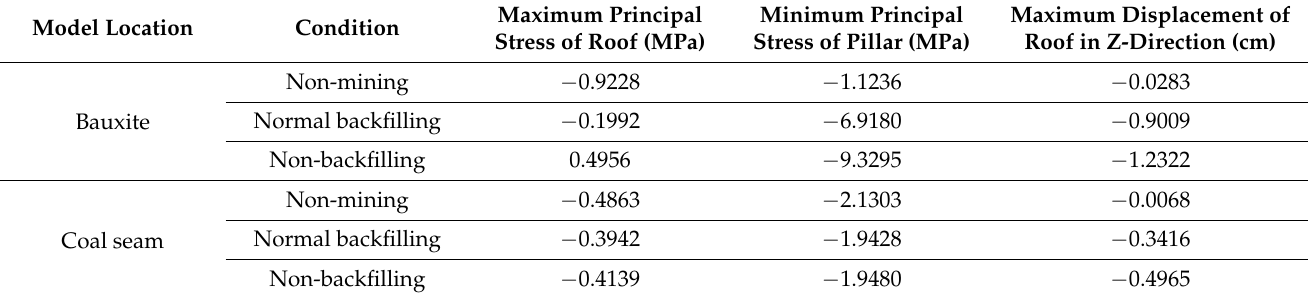
Table 4. Extreme values of principal stress and displacement under different mining conditions.